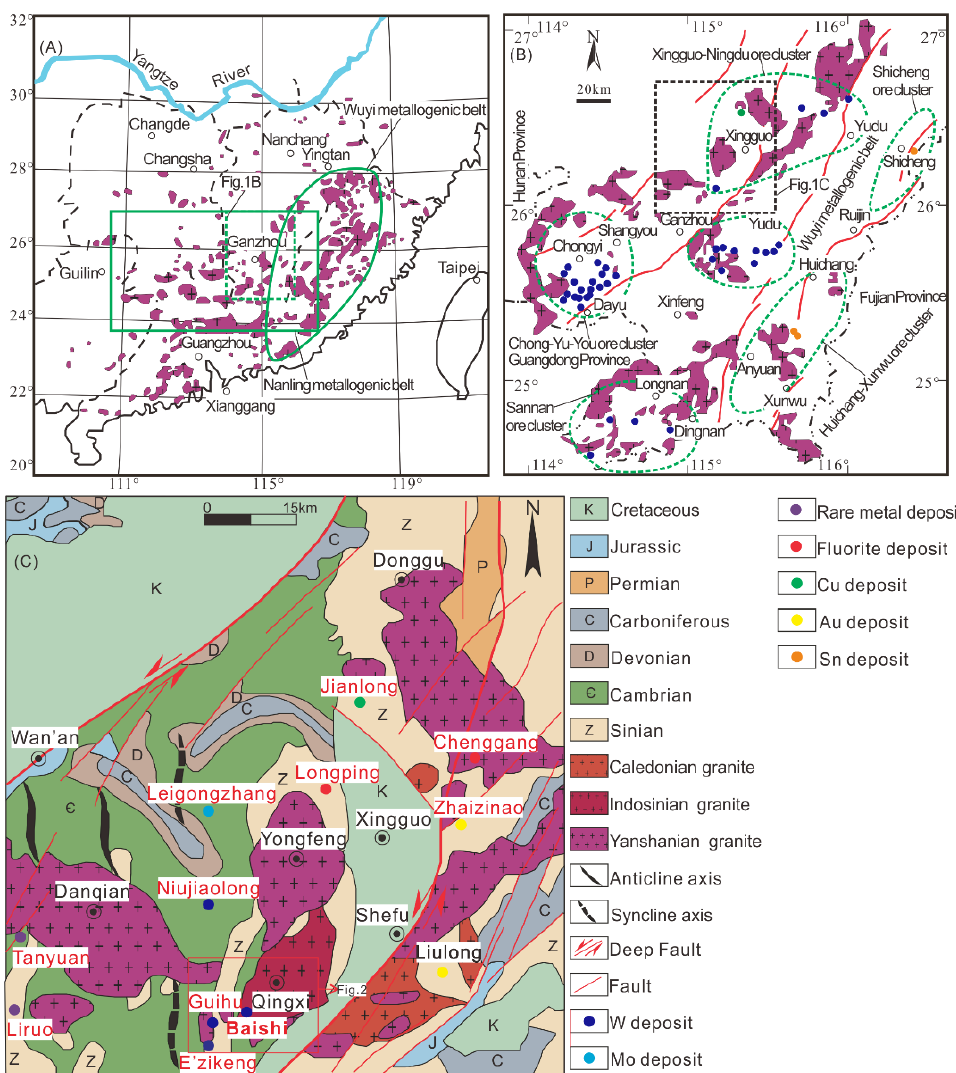
Figure 1. ( A ) Simplified map showing the distribution of Yanshanian granites in South China (modified from [30]). ( B ) Schematic distribution map of tungsten ore cluster and typical W-Sn deposits in South Jiangxi Province (modified from [18]). ( C ) Regional geological map of Baishi W-Cu deposit (modified from [31]).